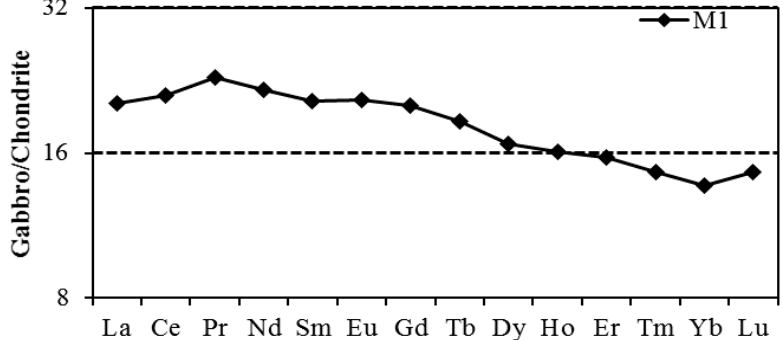
Figure 3. Chondrite-normalized (McDonough and Sun [20]) rare-earth element pattern for